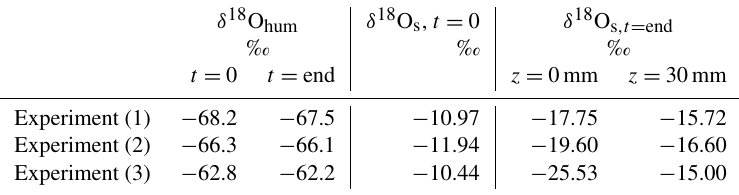
Table 2. δ 18 O is the vapour in the humidifier ( δ 18 O hum ) and of the snow in the sample holder ( δ 18 O s ) at the beginning ( t = 0) and end ( t = end) of each experiment and the final δ 18 O content of the snow in the sample holder at the inlet ( z = 0mm) and outlet ( z = 30mm). Experiment (1) corresponds to the isothermal conditions, experiment (2) to air warming and experiment (3) to air cooling in the snow sample. δ 18 O hum δ 18 O s , t = 0 δ 18 O s ,t = end ‰ ‰ ‰ t =